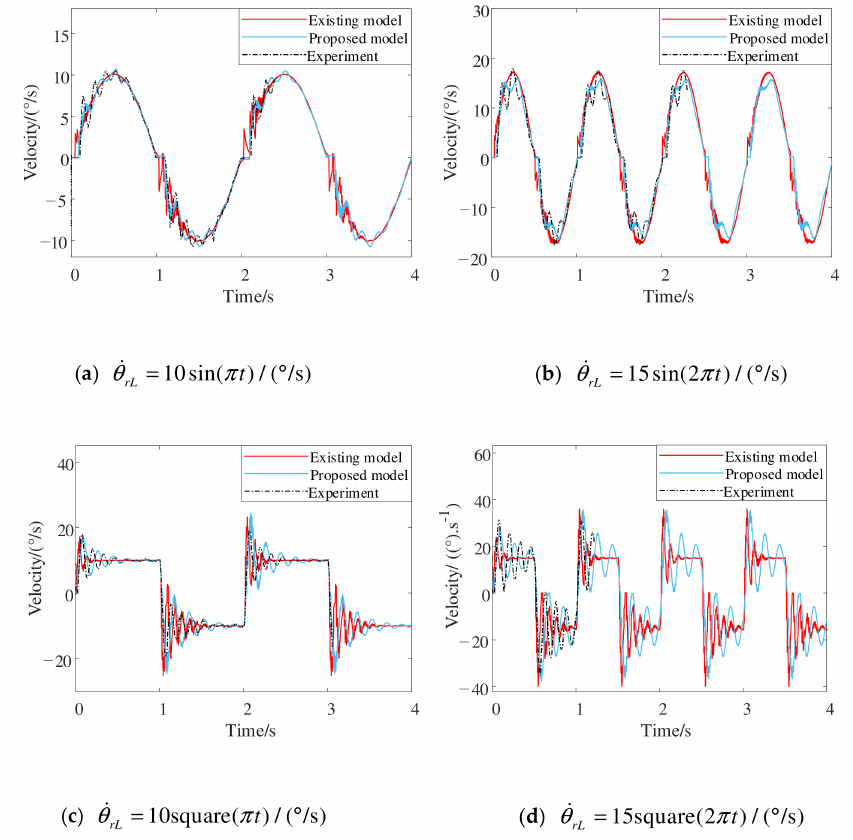
Figure 18. Simulated and experimental time responses under a closed-loop.